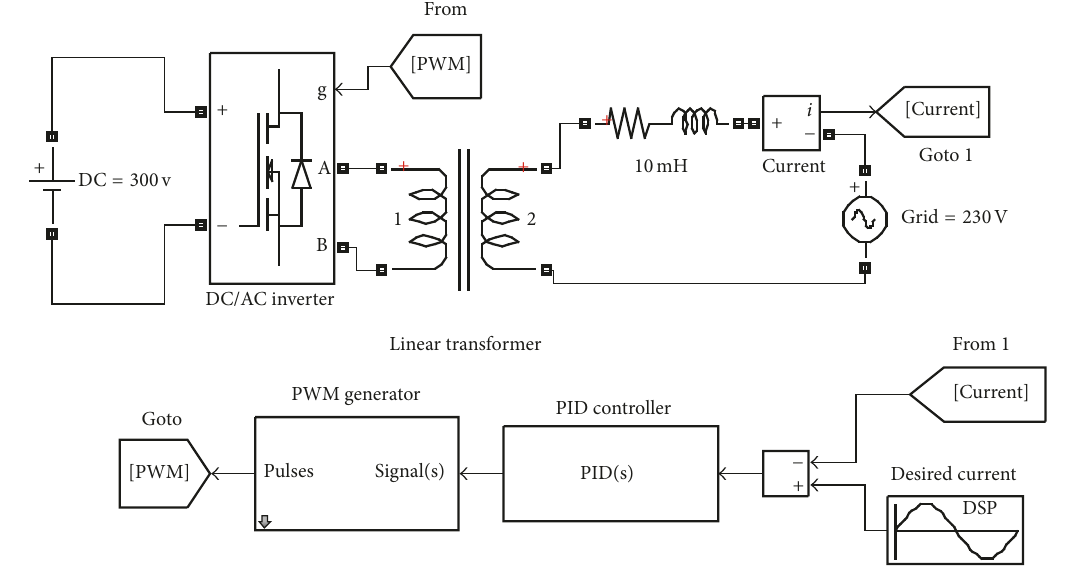
Figure 4: DC/AC grid connected inverter with L-filter used a unit proportional gain controller.